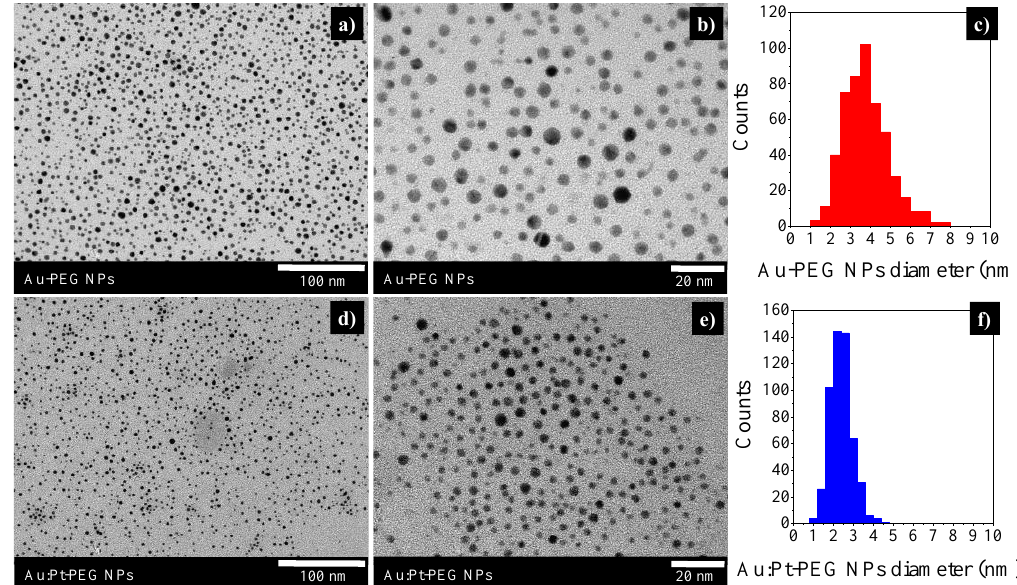
Figure 2. TEM micrographs of Au-PEG NPs ( a ) and Au:Pt-PEG NPs ( d ): scale bar of 1000 nm. Magnified images of Au-PEG NPs ( b ) and Au:Pt-PEG NPs ( e ): scale bar of 20 nm. DLS measurements of Au-PEG NPs ( c ) and Au:Pt-PEG NPs ( f ). NPs, nanoparticles.